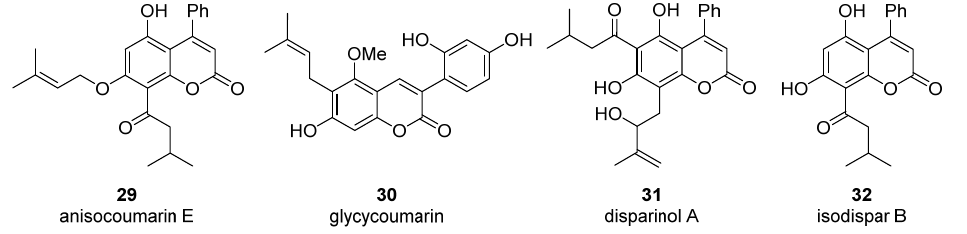
Figure 4. C,O-diterpenoid and phenyl-substituted mono- and diterpenoid coumarins with anti- HIV activity.